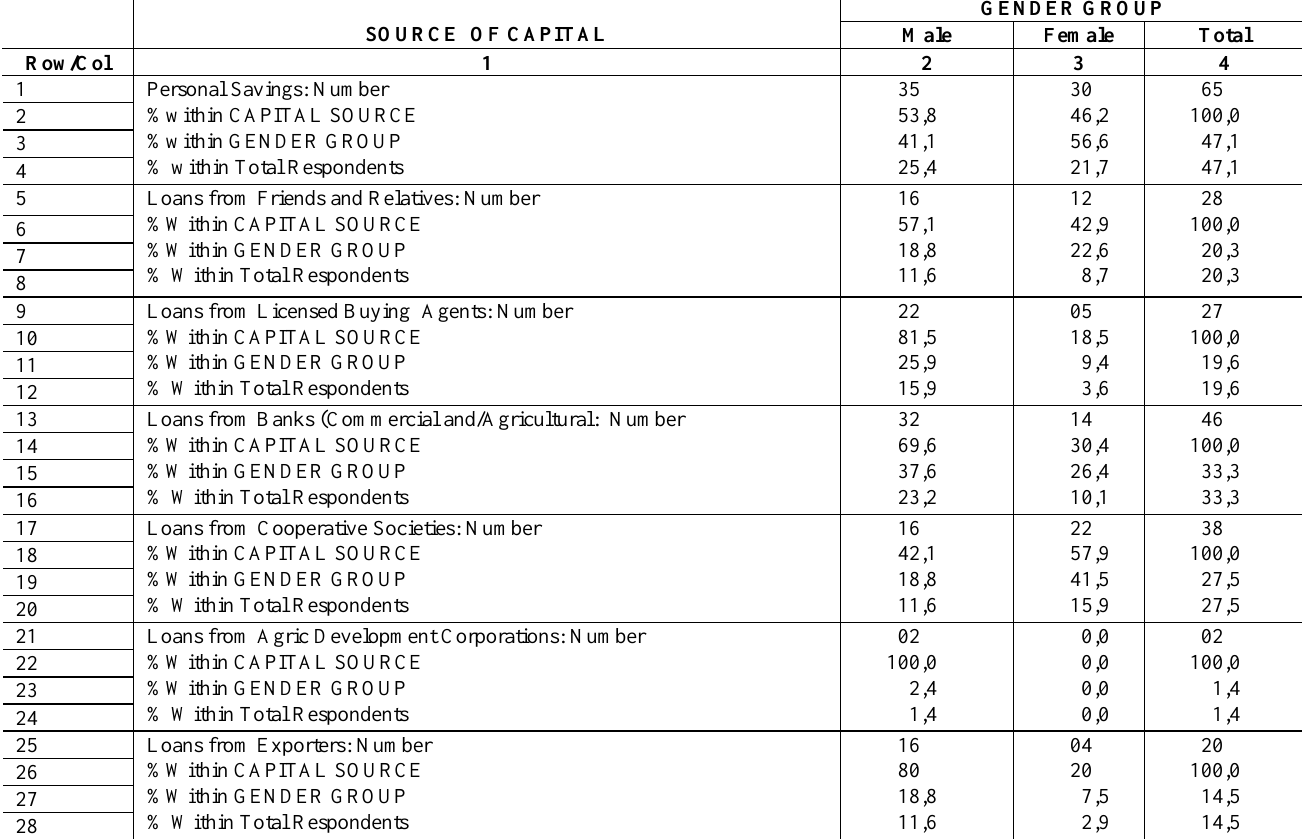
Table 8: Sources of capital by gender: Cocoa marketers in Idanre, Ondo State; 2000/2001 Season GENDER GROUP SOURCE OF CAPITAL Male